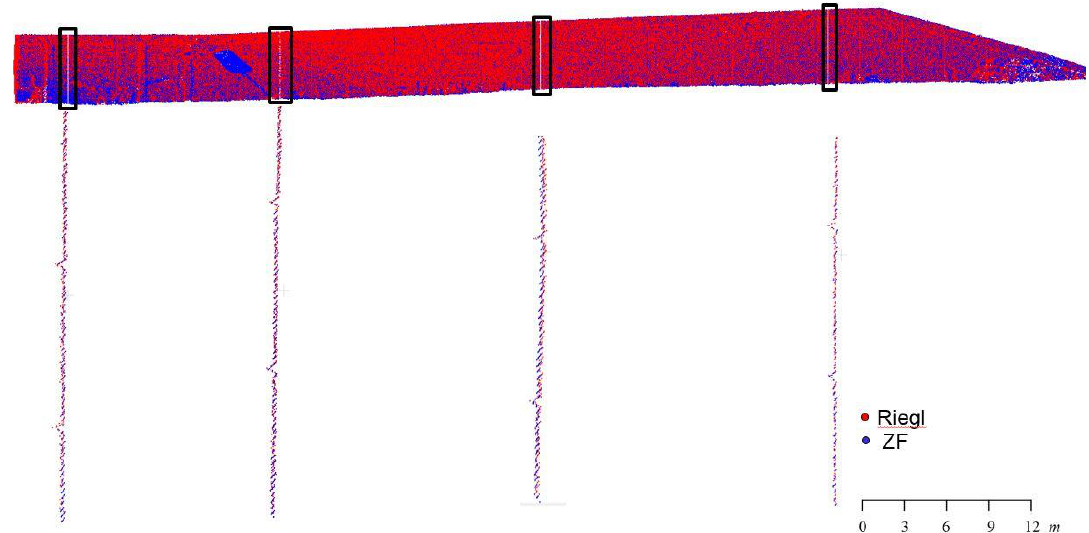
Figure 26. Cross sections illustrating the alignment quality of the Riegl and ZF point clouds from a given drive run of the MSE wall at Site-2.